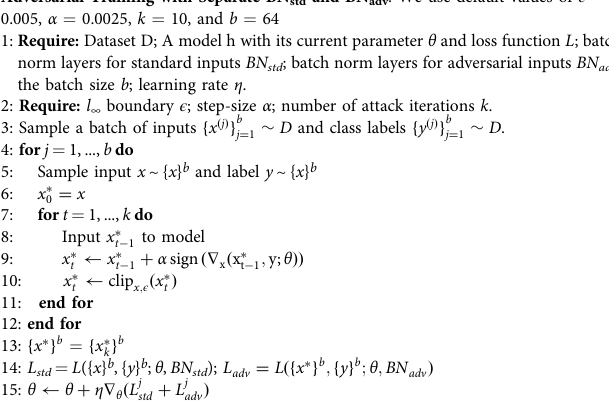
Algorithm 1 Adversarial Training with Separate BN std and BN adv . We use default values of ϵ = 0.005, α = 0.0025, k = 10, and b =